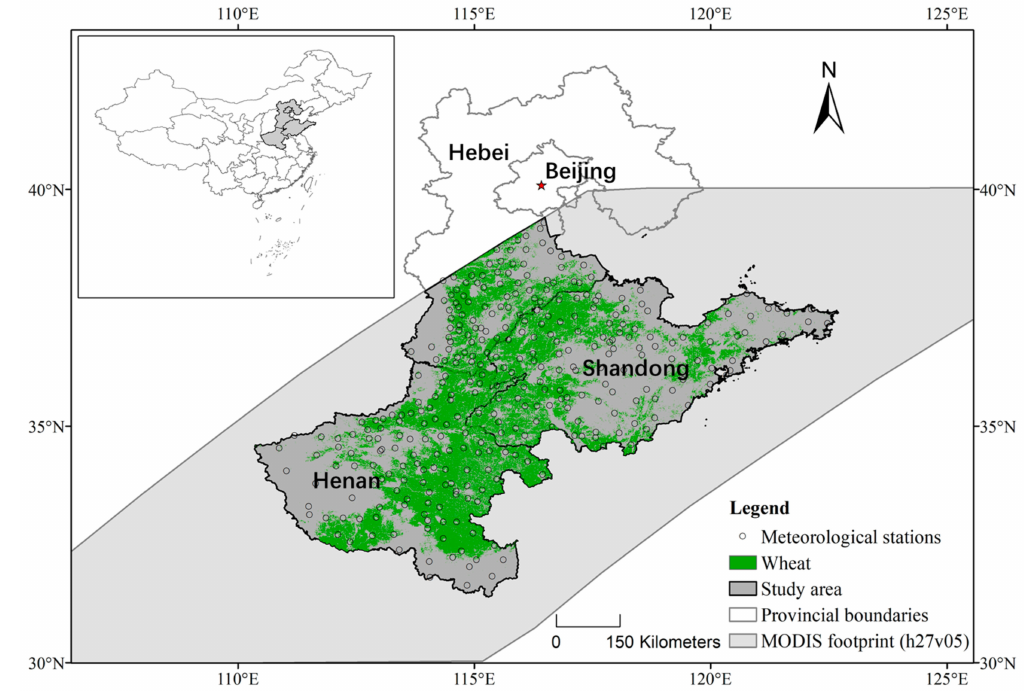
Figure 5. Study area and locations of meteorological